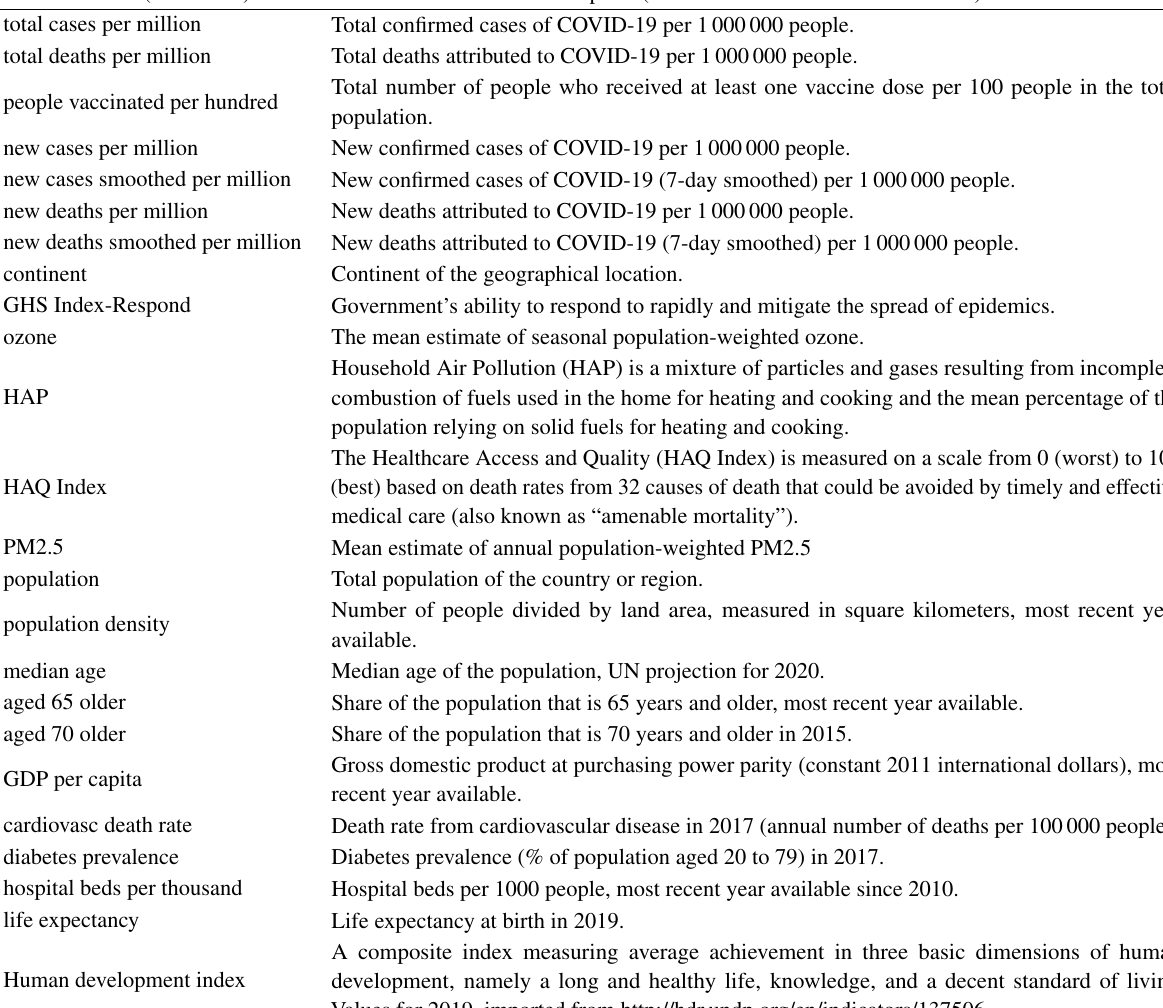
Table 1A Studying variables and statistical